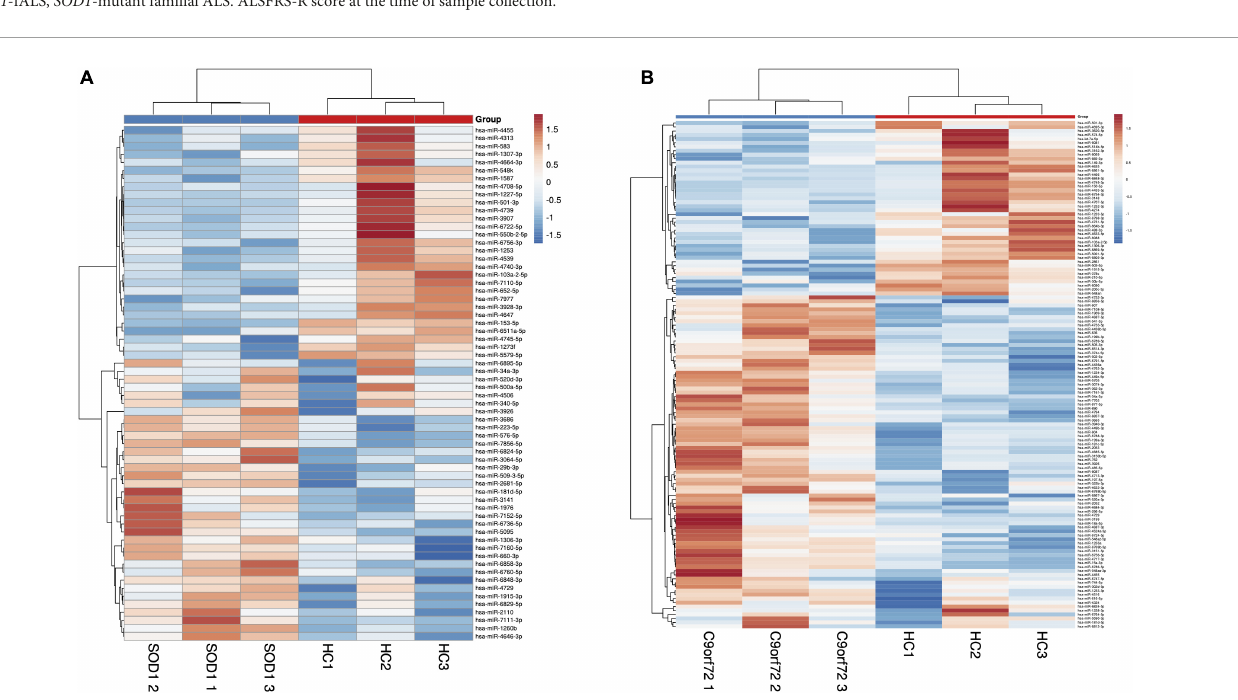
linear regression: Y = 19.85 ∗ X + 47.80) ( Supplementary Figure 4A